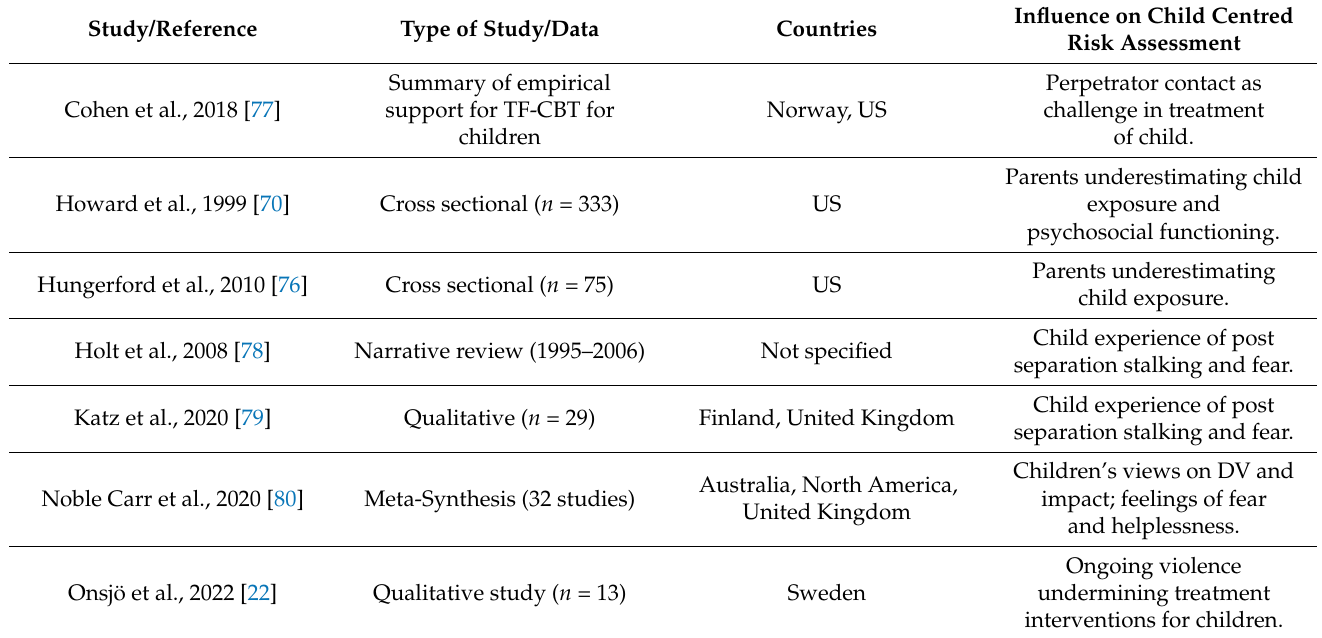
Table 3. The Child’s